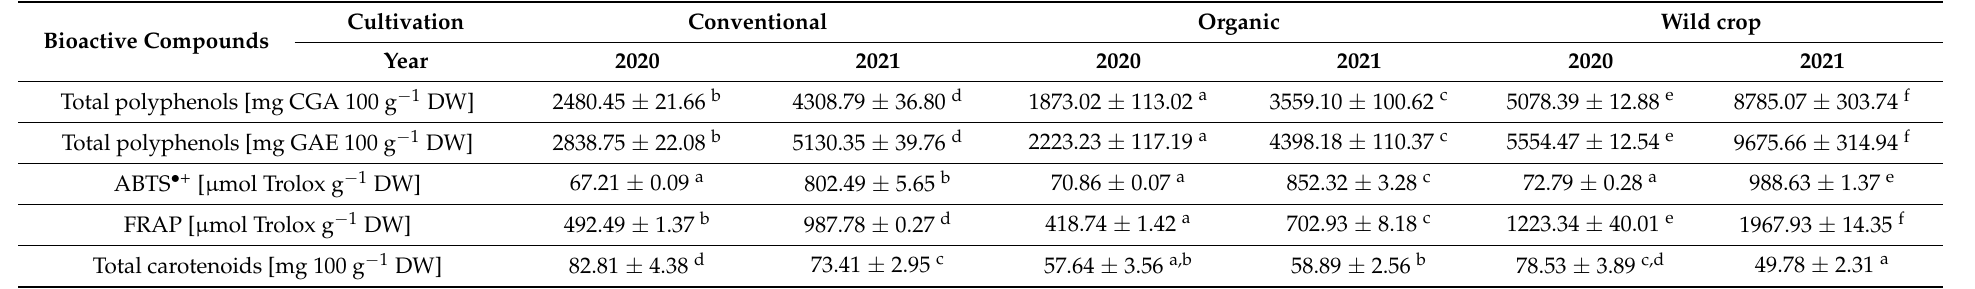
Table 7. Total polyphenol, carotenoids and anthocyanins content as well as antioxidant activity of the leaves of three raspberries cultivation at different harvest (2020 and